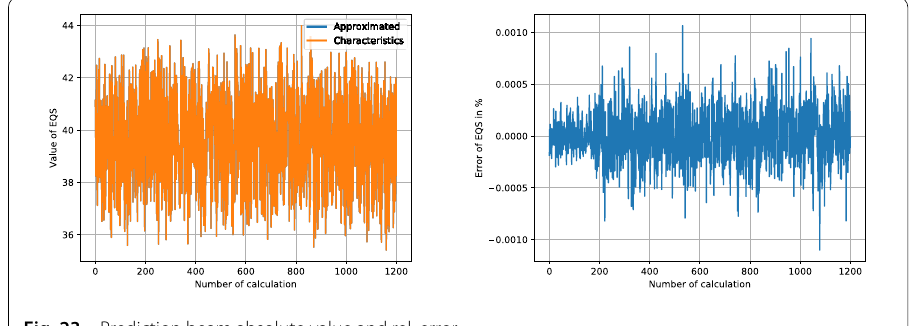
Fig. 23 Prediction beam absolute value and rel. error